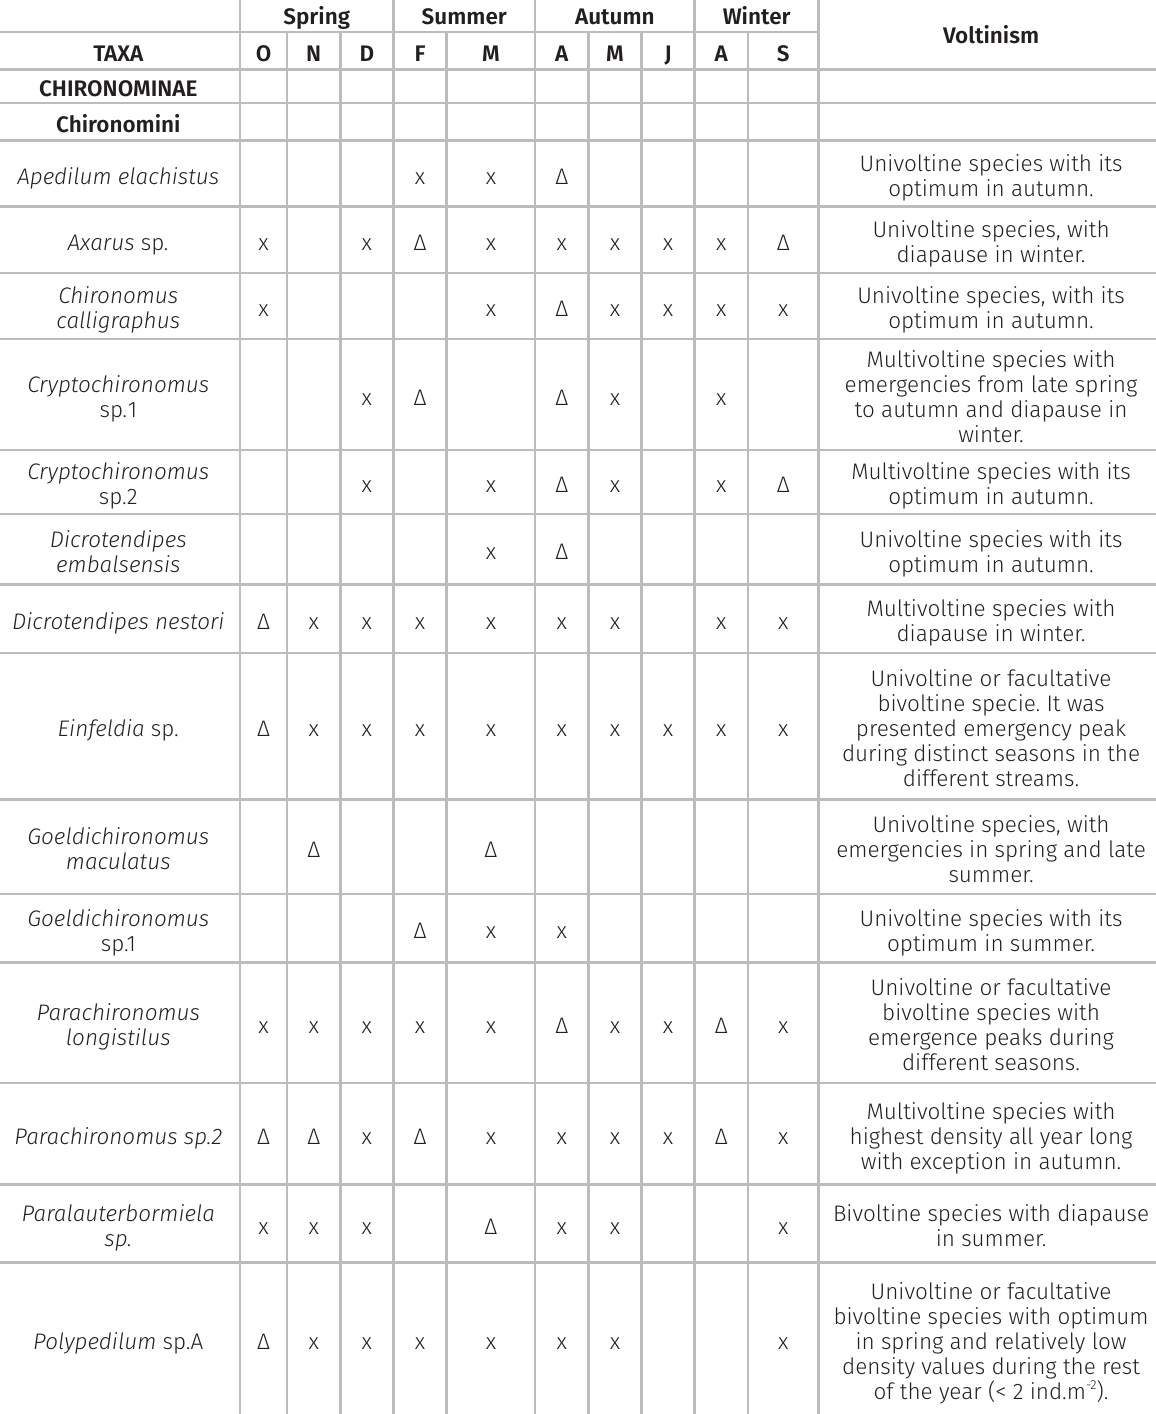
Table I. List of Chironomidae (Diptera) collected in pampean streams. The emergence period, emergence peak (Δ) and Voltinism are shown. Summer